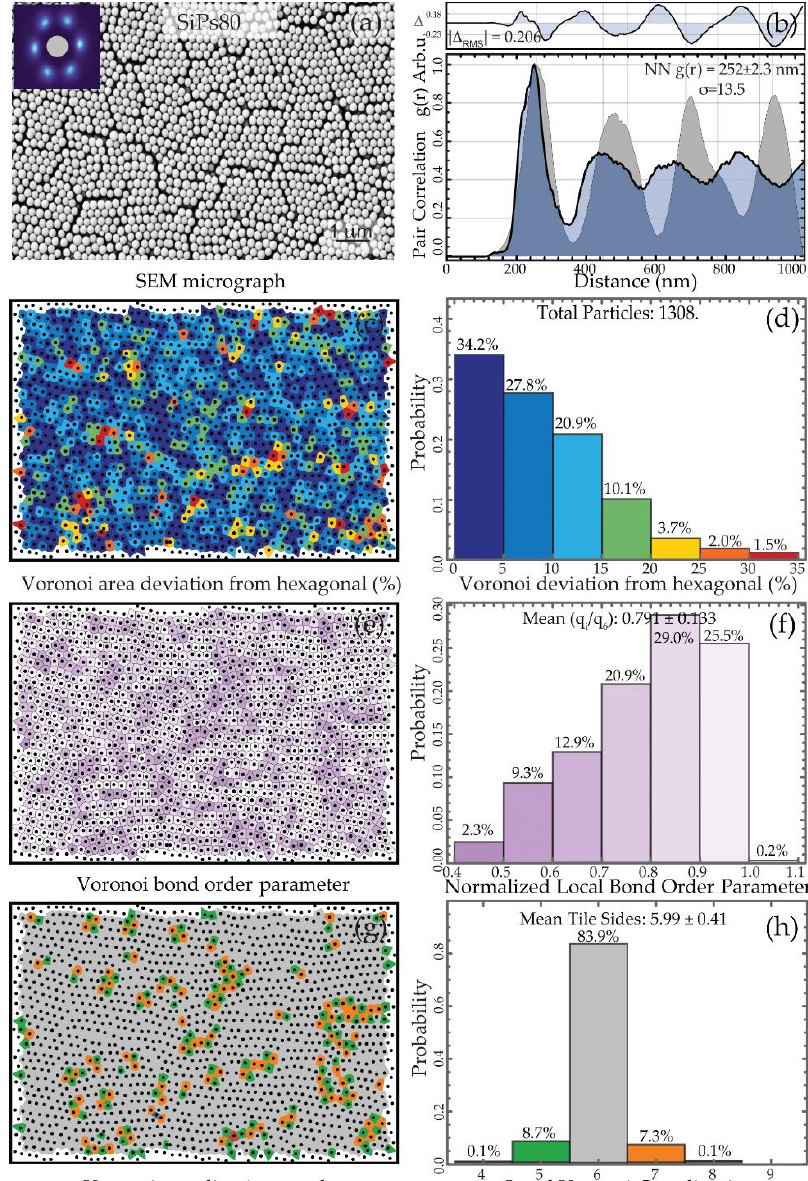
Figure A3. Spatial statistics of sedimented SiPs80. ( a ) SEM image with insert of coordination map or fast Fourier transform (FFT) showing six distinct lobes as expected for hexagonally packed systems. ( b ) pair correlation function for the particle distributions (blue) and that of the matched hexatic lattice (grey). Using the average spacing (2r hex ) of a hexagonal lattice with the same number density (located at particle positions), the matched hexatic lattice is determined by randomly displacing the particles from their center with a mean distance relative to a normal probability distribution. The widths of these peaks correspond to the average mean displacement each particle has relative to this expected spacing, described by the lattice disorder parameter, σ . The nearest neighbor distance can be determined from the maximum of the first peak in the g(r) . The insert above shows the difference spectrum, which is the subtraction between the pair correlation func- tion and the hexatic lattice. ( c ) Voronoi tessellations of the particle centroids colored by percent